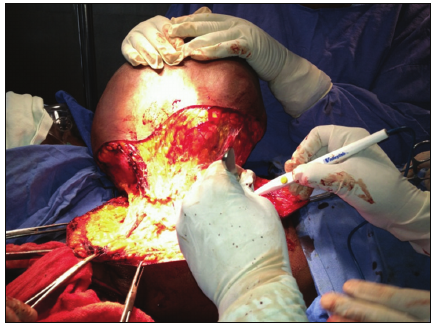
Figure 3: Intraoperative picture showing separation of the tumour from chest wall.